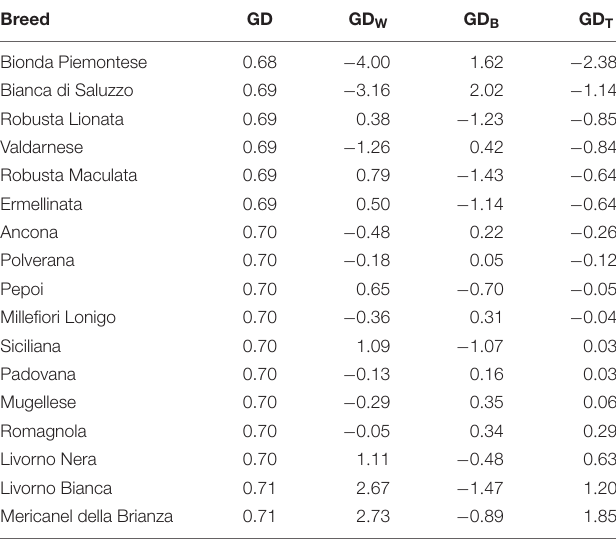
TABLE 3 | Breed impact on global